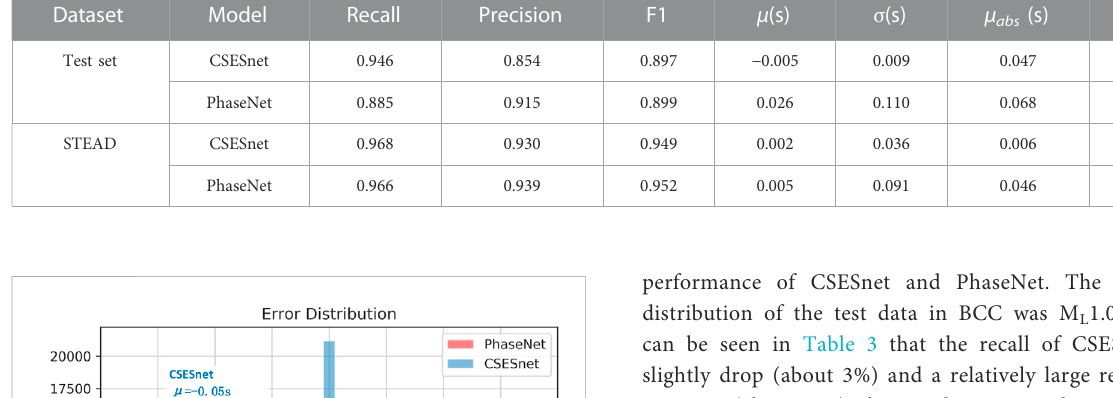
TABLE 2 P-wave picking performance of CSESnet and PhaseNet on test set and STEAD. Dataset